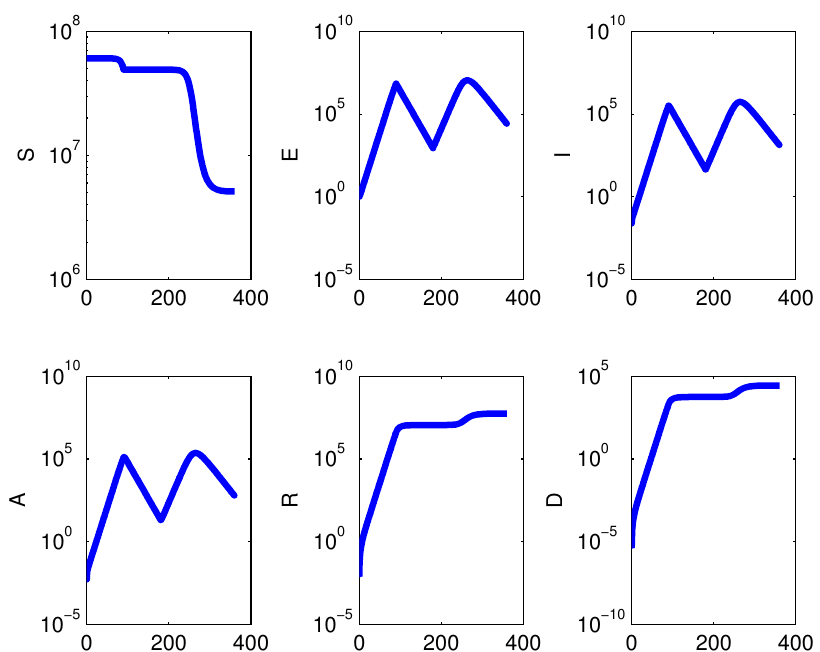
Figure 13. The semilogarithmic plot of the epidemic’s spread with the lock-down policy, implemented from time 90 up to time 180, with the reduced contact rate β I = 10 − 10 , after which β I = 10 − 7 resumes. The simulation runs over a one year timespan for the model (1) with demographics. Left to right and top to bottom, the subpopulations are: S , E , I , A , R and D , the disease-related deceased